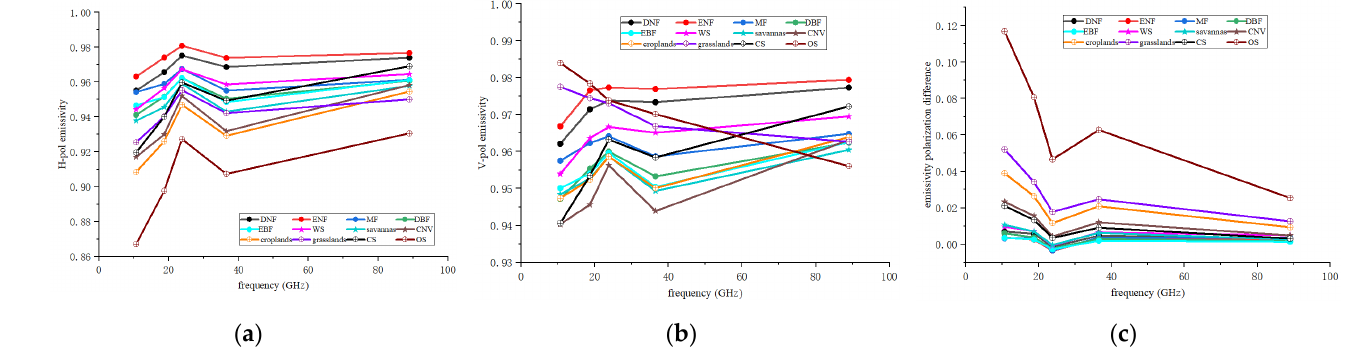
Figure 3. Relationship between microwave emissivity and frequency for 12 vegetation types in summer from 10.65 to 89 GHz: ( a ) variations in mean emissivity of H-pol; ( b ) variations in mean emissivity of V-pol; ( c ) variations in mean emissivity polarization difference.